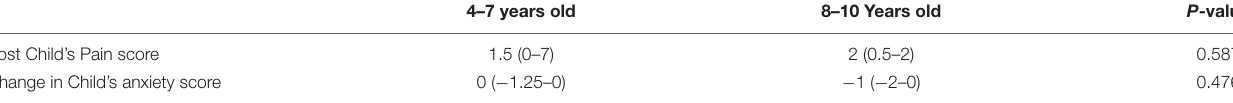
TABLE 5 | Association of age with scores.